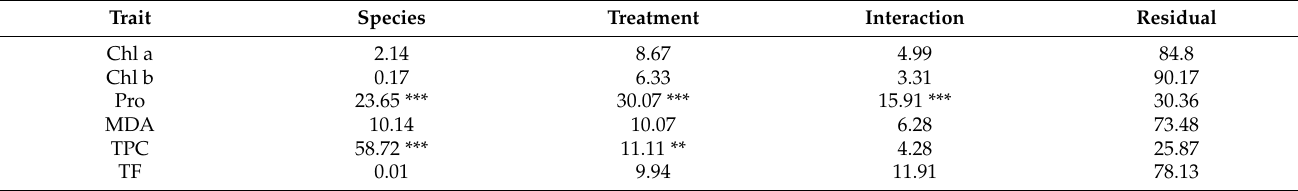
Table 4. Two-way analysis of variance (ANOVA) of species, treatment and their interactions for the biochemical parameters analysed.